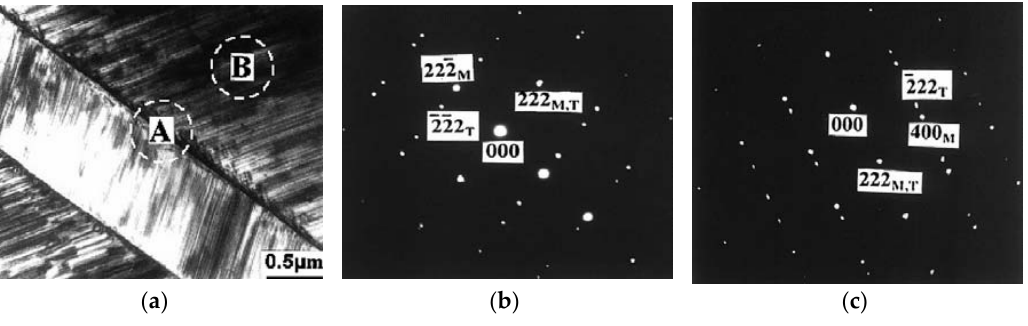
Figure 22. ( a ) TEM bright-field image of Ni 54 Mn 25 Ga 21 alloy ( b ); SAED pattern in the [1 1 0] taken from area A in ( a ); ( c ) SAED taken from area B in ( a ) with the incident electron beam tilted to [0 1 1] [171], with copyright permission from © Elsevier.